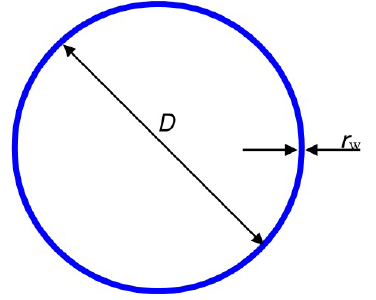
Figure 24. Loop antenna schematic.